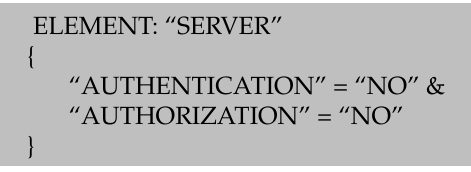
Figure 4. An example for an